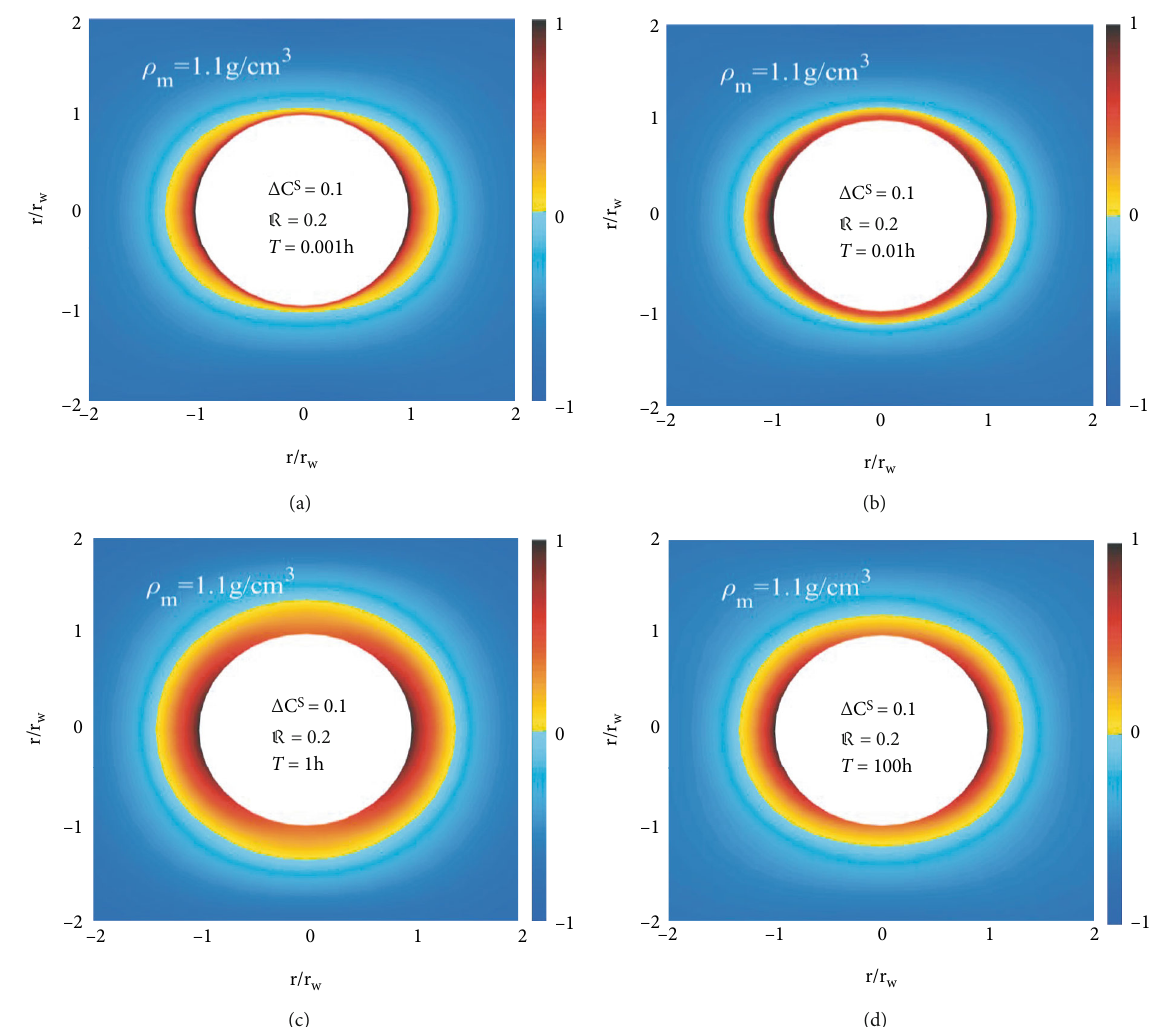
Figure 18: Damage zone around the wellbore of drilled in shallow soft shale (a) 0.001h, (b) 0.01h, (c) 1 h, and (d) 100h after